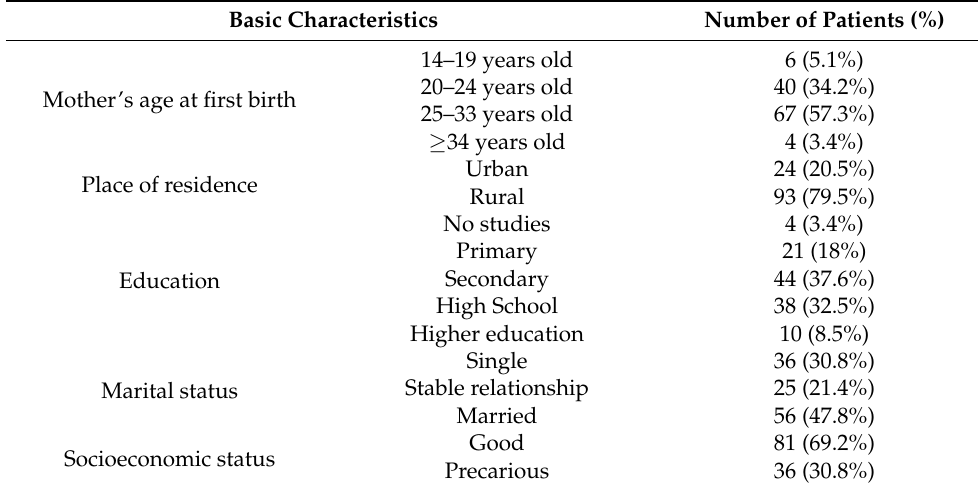
Table 2. Basic characteristics of pregnant women living with HIV.